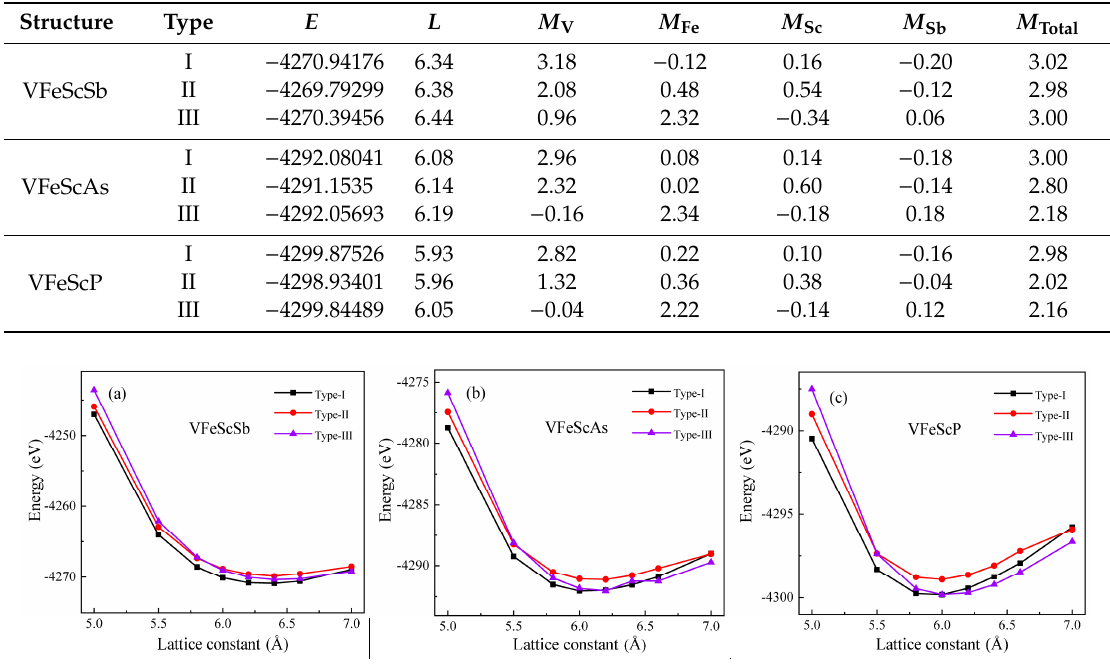
Figure 3. Total energy as a function of lattice constant in the Heusler alloy ( a ) VFeScSb, ( b ) VFeScAs, and ( c ) VFeScP with type-I, -II, and -III structures. Figure 2. Type-I structure of the quaternary alloy VFeScZ (Z = Sb, As, P).